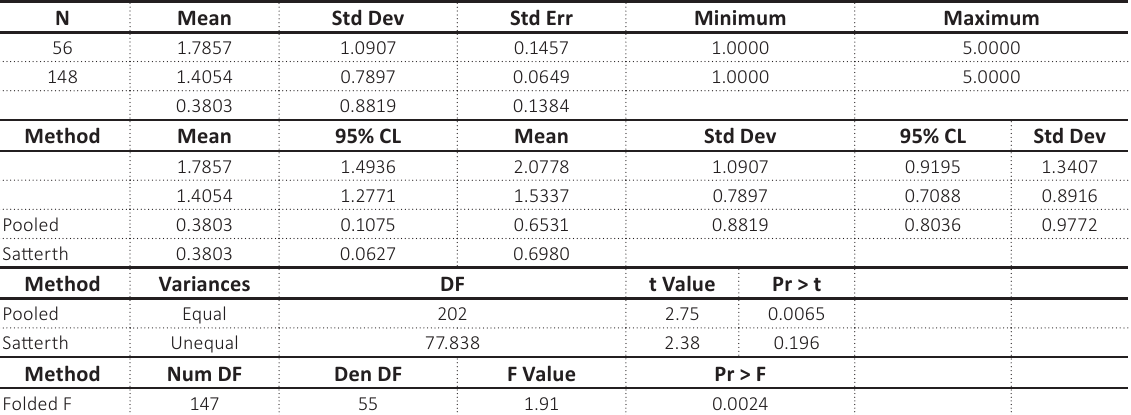
Source: Authors’ processing using SAS software.